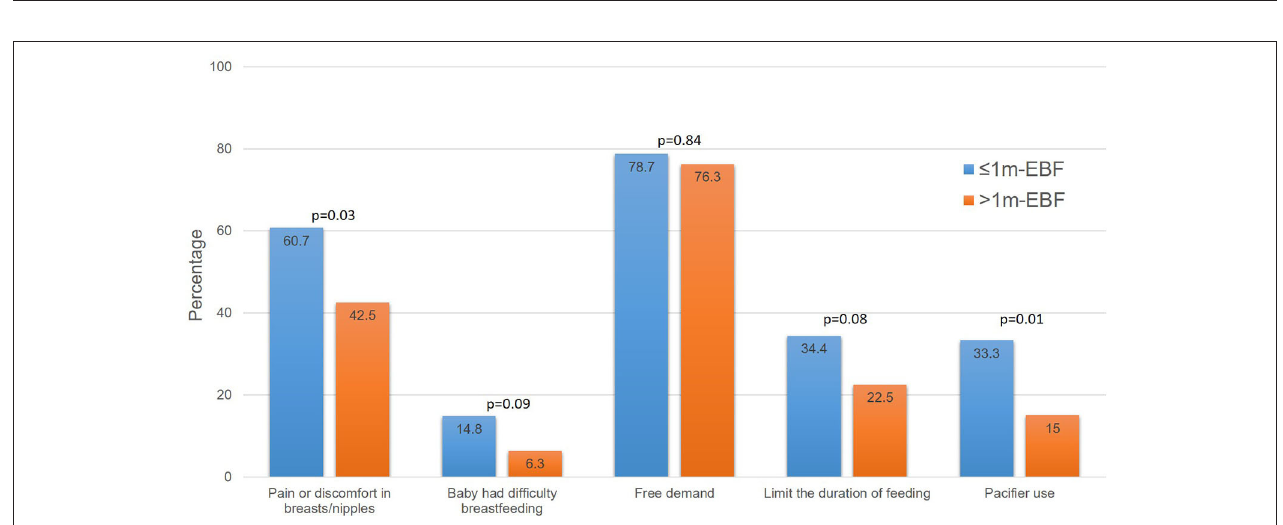
FIGURE 4 | Breastfeeding practices during hospitalization. Groups were compared using the chi-square test.